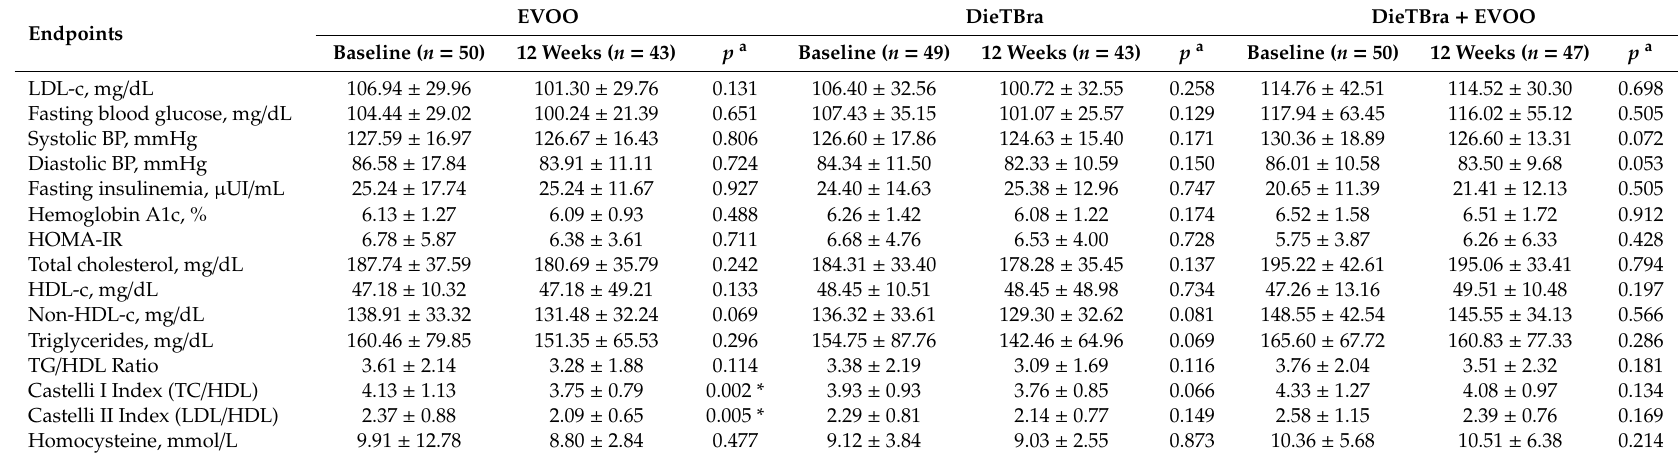
Table 2. Comparison of mean values at baseline and at the end of follow-up for cardiometabolic risk factors in severely obese individuals according to each intervention